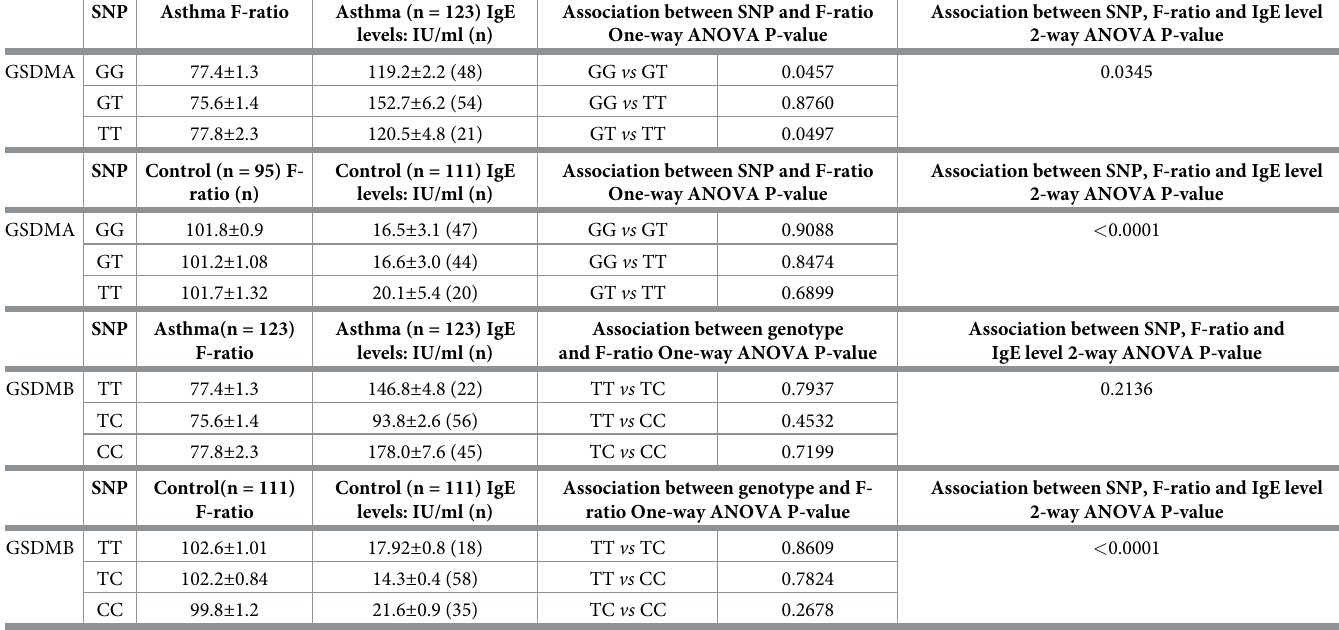
Table 4. Association of the lung function for the adult asthmatic patients with GSDMA and GSDMB and IgE